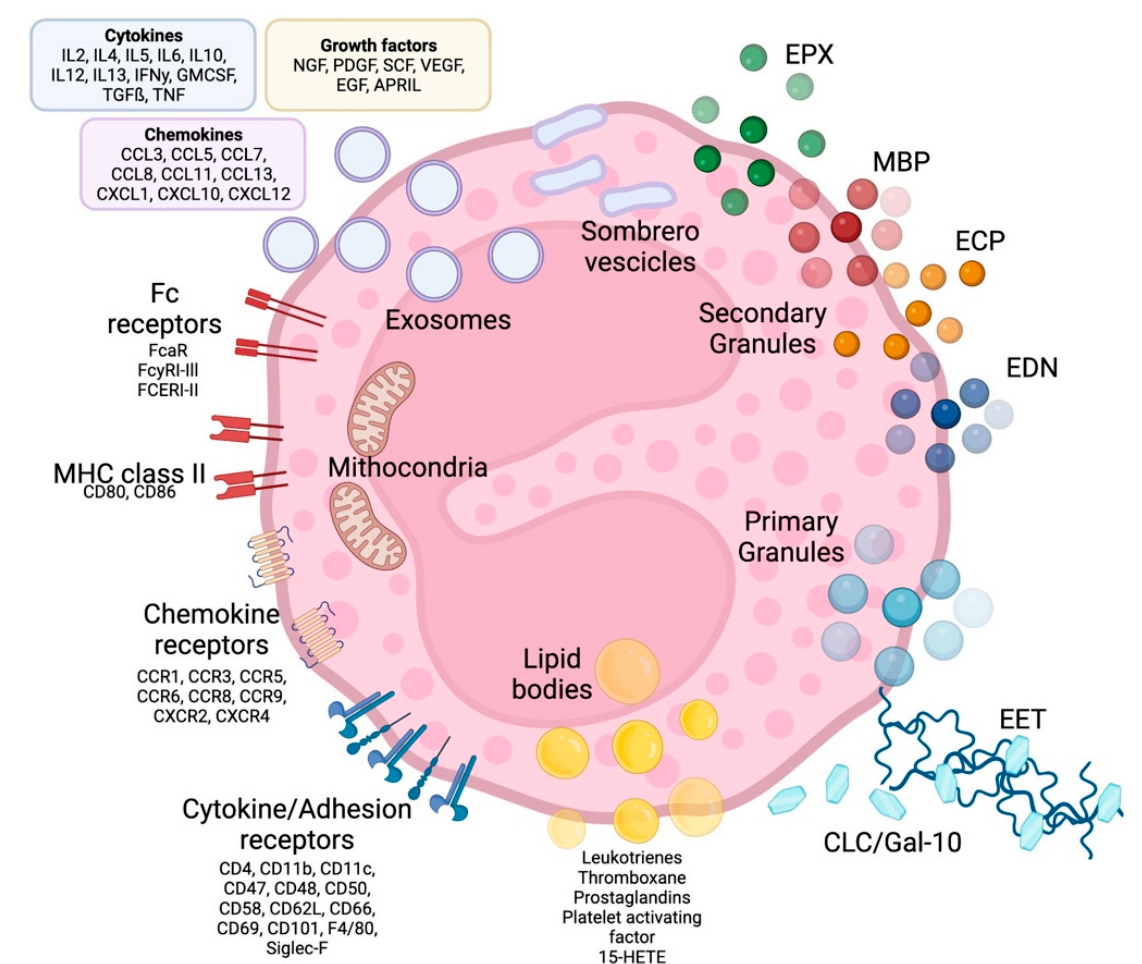
Figure 1. Eosinophil structure, granules, surface receptors, exosomes and EETs. Eosinophils are supplied by a large number of proteins, receptors and enzymes that allow them to interact with the microenvironment and express a number of receptors on their surface, including receptors for cytokines, chemokines and lipid mediators, which are involved in cell growth, survival, adhesion, migration and activation. In addition to receptors, adhesion molecules such as integrins are expressed on the cell surface, which allows eosinophils to migrate and react to several stimuli. The effects of eosinophils are largely achieved due to the content of their granules. Primary granules include Charcot-Leyden/galectin-10 protein, a characteristic eosinophilic protein implicated in asthma and parasitic infections, as well as a constituent part of so-called eosinophilic extracellular traps, whose other major constituents are nuclear or mitochondrial DNA strands. Specific or secondary granules contain four main cationic proteins: MBP, ECP, EPX and EDN. In addition, some of the content of the granules is released through particular vesicles called sombrero vesicles. Each of them has different effects, clarified in the text. Lipid bodies contain prostaglandins, thromboxane and leukotrienes, which participate in allergic inflammation, fibrosis and thrombosis. Finally, eosinophils are able to release exosomes that fuse with the cell membrane, which are involved in epithelial damage. CLC/Gal-10: Charcot-Leyden crystal proteins; ECP: eosinophil cationic protein; MBP: major basic proteins; EPX: eosinophil peroxidase; EDN: eosinophil-derived neurotoxin; MHC class II: Mayor histocompatibility complex-II; EET: eosinophilic extracellular traps. See the text for further